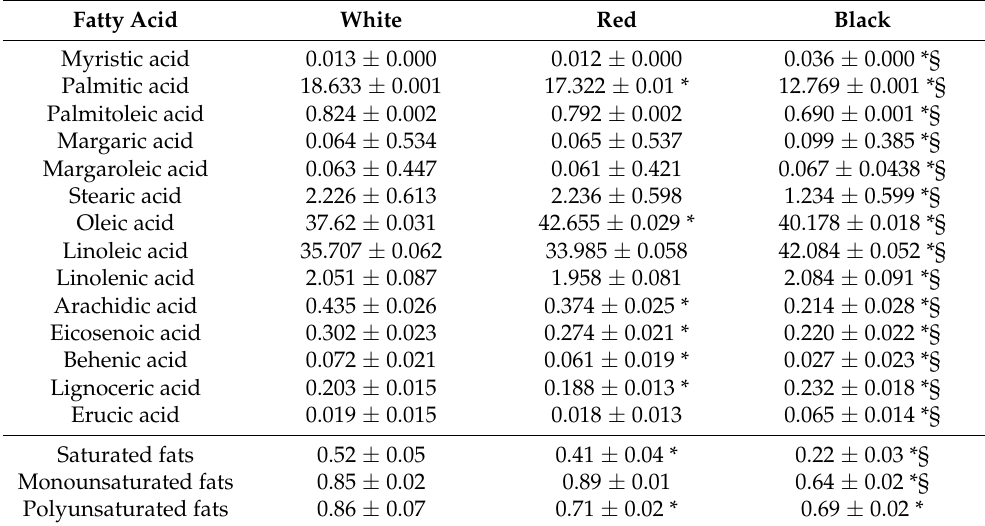
Table 3. Fatty acid content (g per 100 g raw fat) of white, red, and black sorghum varieties. Fatty Acid White Myristic